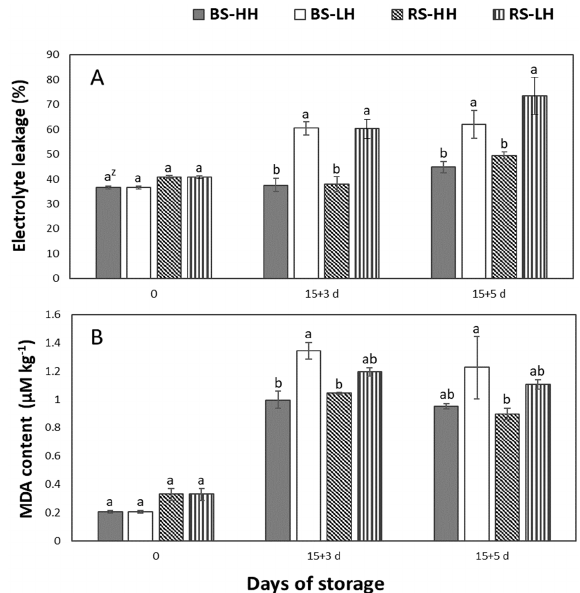
Figure 3. High and low RH effects on sweet pepper’s electrolyte leakage ( A ) and MDA content ( B ) before and during ambient conditions after 15 days of cold storage at 5 °C. Vertical bars represent ± SE of the mean ( n = 3). Z Different letters represent significant differences among treatments for each sampling day using Tukey’s multiple comparison test at p ˂ 0.05. Note: 15 + 3 d means the third day in ambient conditions, and 15 + 5 d means the fifth day in ambient conditions.